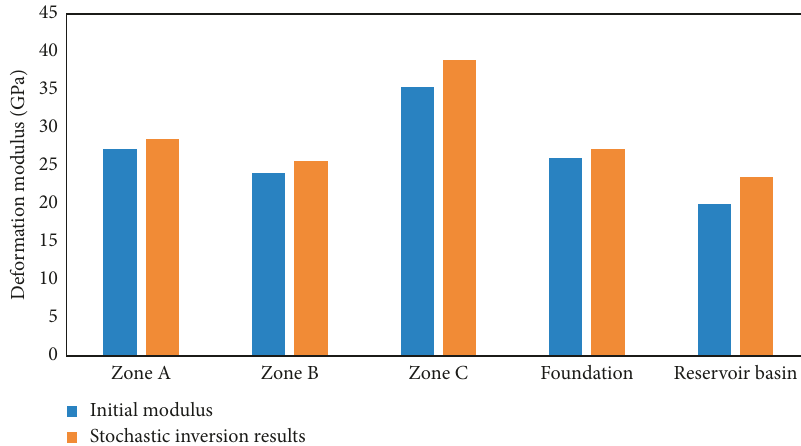
Figure 12: Comparison between the initial modulus and the stochastic inversion results.